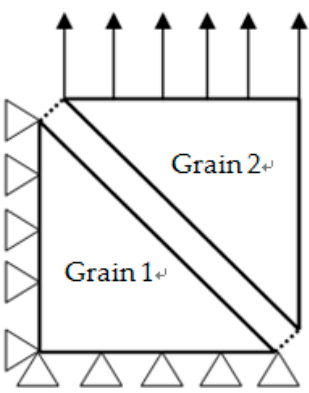
Figure 6. Schematics showing the second bi-grain case study to validate the sliding